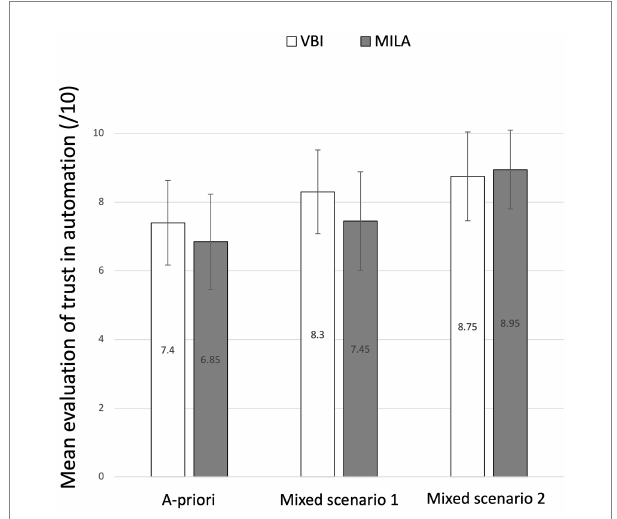
FIGURE 5 Graphic representation of the mean score to the trust scale, depending on the interface and the moment of the measure. Error bars represent the standard